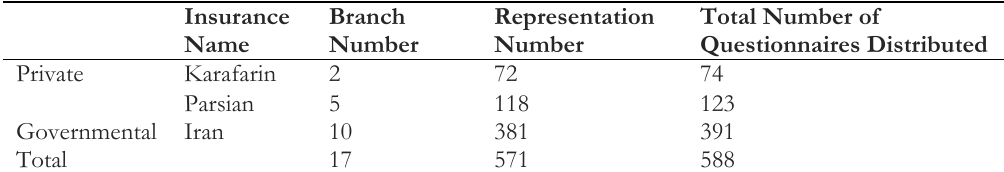
Table 3. Questionnaires distributed in the insurance